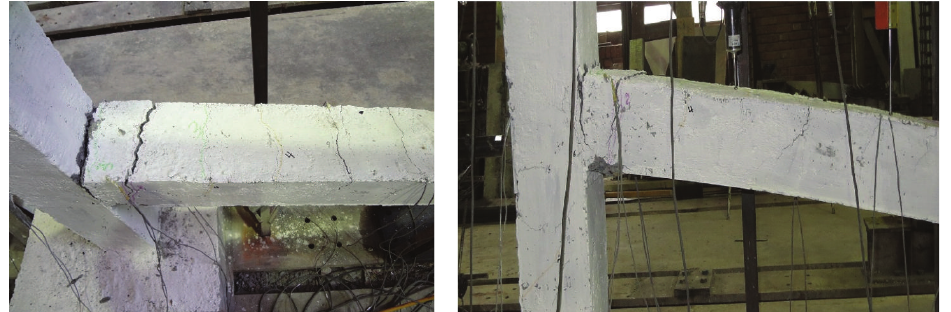
Figure 7: Crack pattern in south end of the specimen.